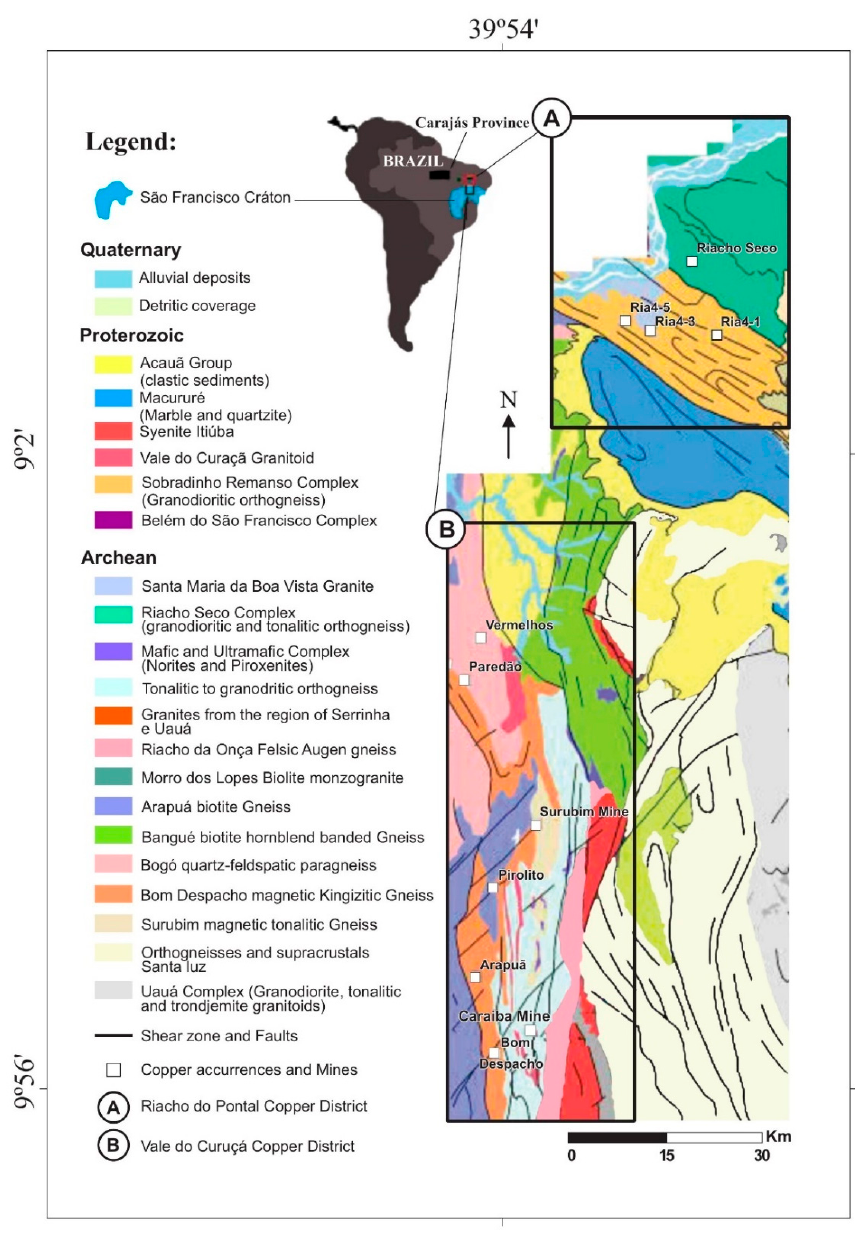
Figure 1. Geologic map showing the study location with ( A ) the Riacho do Pontal and ( B ) the Vale do Curaçá copper districts. Major copper mines and occurrences are shown [20,27,31].